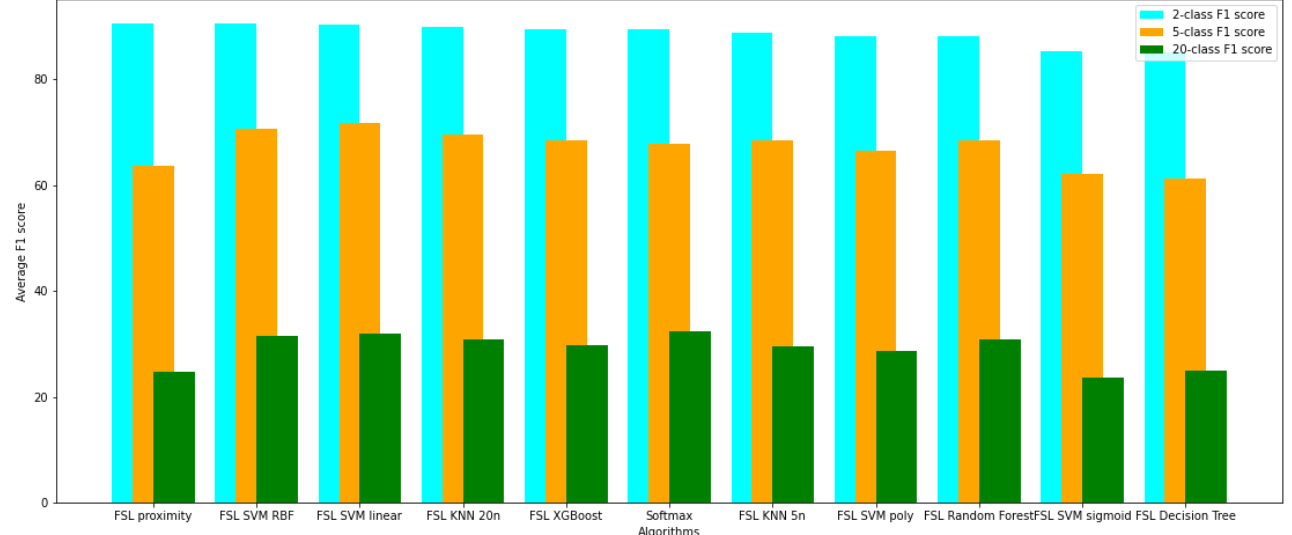
Figure 7. Comparison of average F1 score of evaluated models on 2, 5, and 20 classes detection.